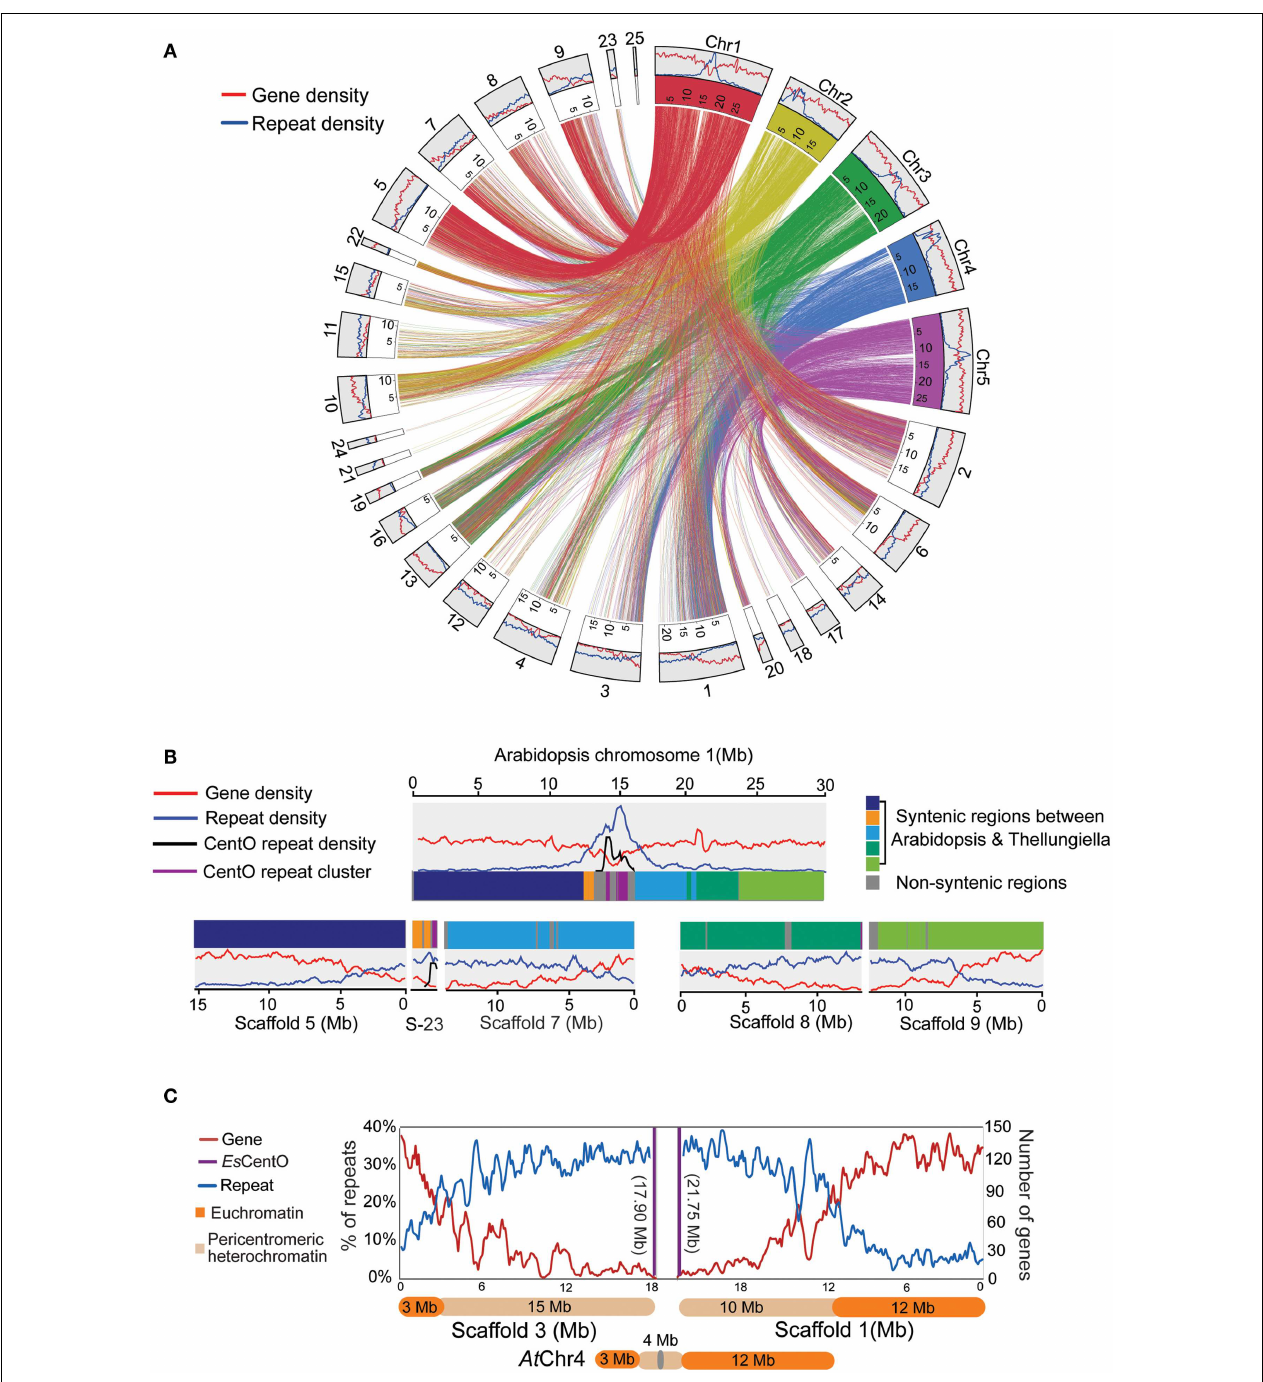
FIGURE 3 | Dramatic expansion of pericentromeric heterochromatin in E. salsugineum . (A) Macro-synteny between the 25 largest scaffolds in E. salsugineum and the five chromosomes in A. thaliana . (B) Scaffolds 5, 7, 8, 9 are in synteny with At Chr1. (C) Scaffolds S1 and S3 are in synteny with At Chr4.